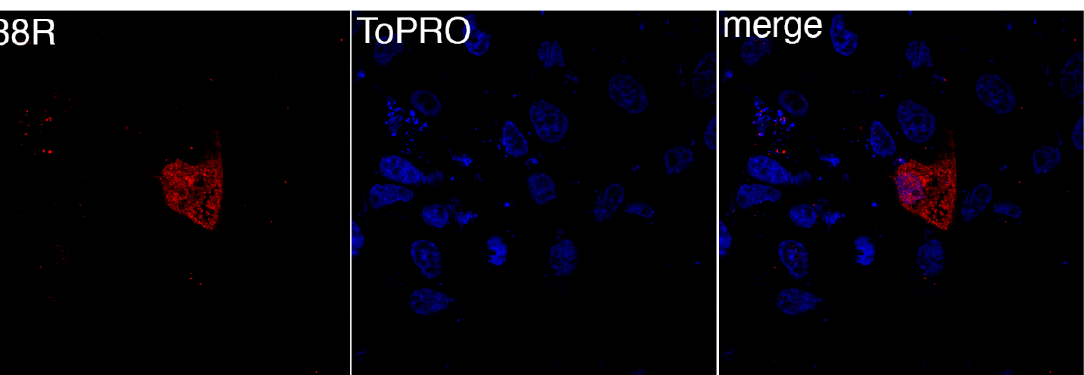
Figure 1. FV3 88R localizes to the cytoplasm. Baby Green Monkey Kidney (BGMK) cells were transfected with pcDNA3 ‐ 88R. 48 hours post transfection, cells were fixed, and indirect immunofluorescence was performed using rabbit anti ‐ myc antibodies (red) and TO ‐ PRO ‐ 3